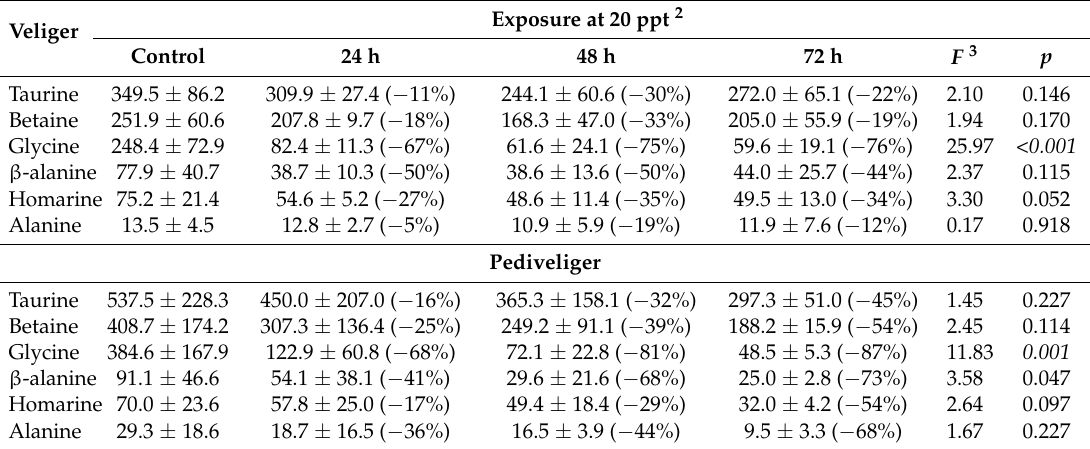
Table 3. Free amino acid concentrations 1 in larval mussels following low salinity exposure.